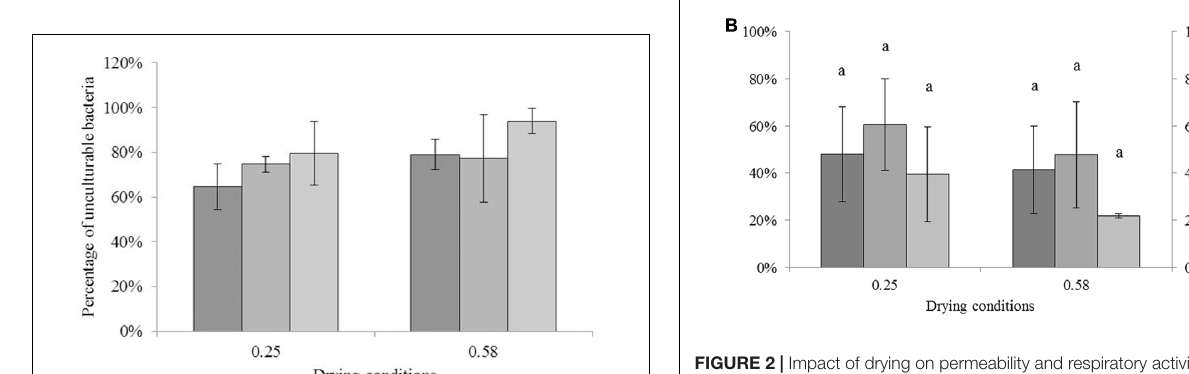
FIGURE 2 | Impact of drying on permeability and respiratory activity of Cronobacter sakazakii , Salmonella Typhimurium, and Salmonella Senftenberg cells. The number of unculturable cells was adjusted to 100% (presented on the left). (A) Impact of drying (16 h) on membrane permeability of each species reported as percentage of unculturable cells. From darker to lighter, bars represent the percentages of permeabilized C. sakazakii , S. Typhimurium, and S. Senftenberg cells (right axis). (B) Impact of drying (16 h) on respiratory activity of each species reported as percentage of unculturable cells. From darker to lighter, bars represent the percentages of non-respiring C. sakazakii , S. Typhimurium, and S. Senftenberg cells (right axis). Error bars represent the standard deviation obtained using independent